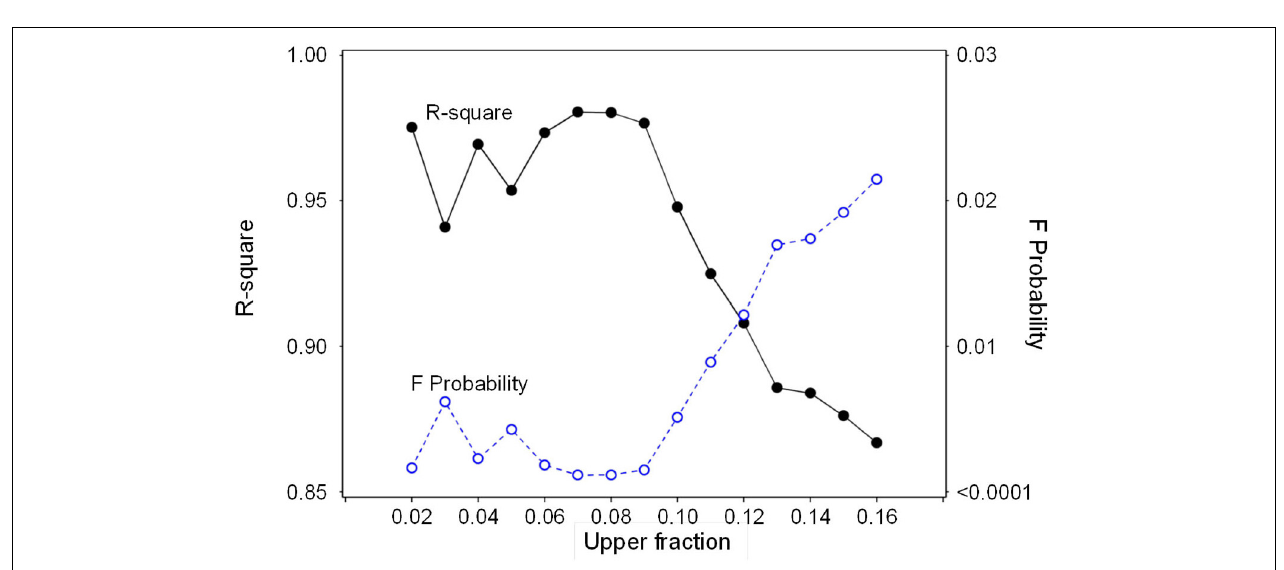
FIGURE 2 | Relation of average SWP to average VPD for representative upper fractions of SWP values from 0.5 kPa classes of VPD. Also shown are the regression lines for each fraction. Only SWP data from the central 5 VPD classes (1.5–3.5 kPa midpoints) were used. Slopes were –0.17, –0.18, –0.19, and –0.18, and intercepts were –0.29, –0.34, –0.40, and –0.46, respectively for fractions of 0.03, 0.07, 0.11, and 0.15.